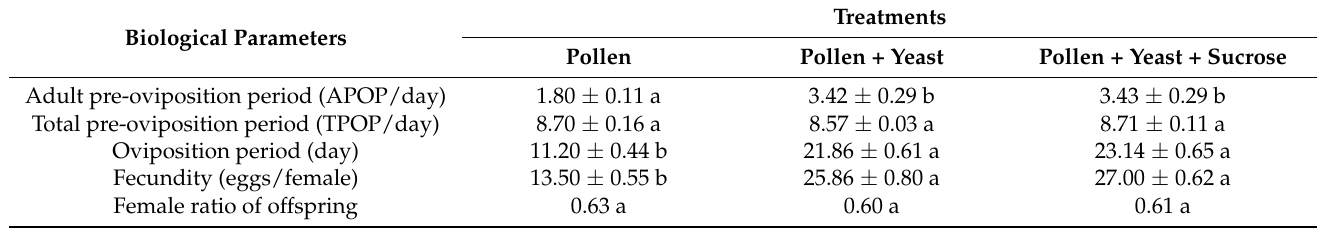
Table 3. The biological parameters of Amblyseius orientalis individuals in the different treatment